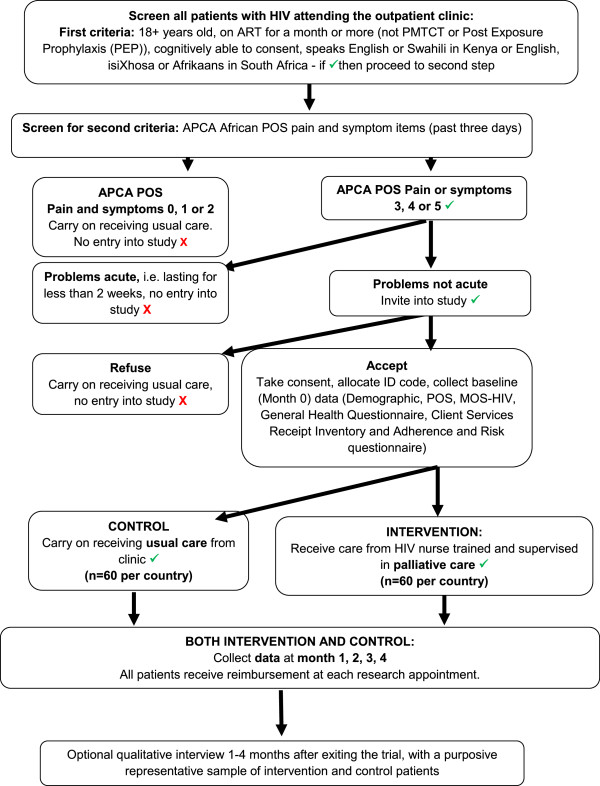
Study flow chart.